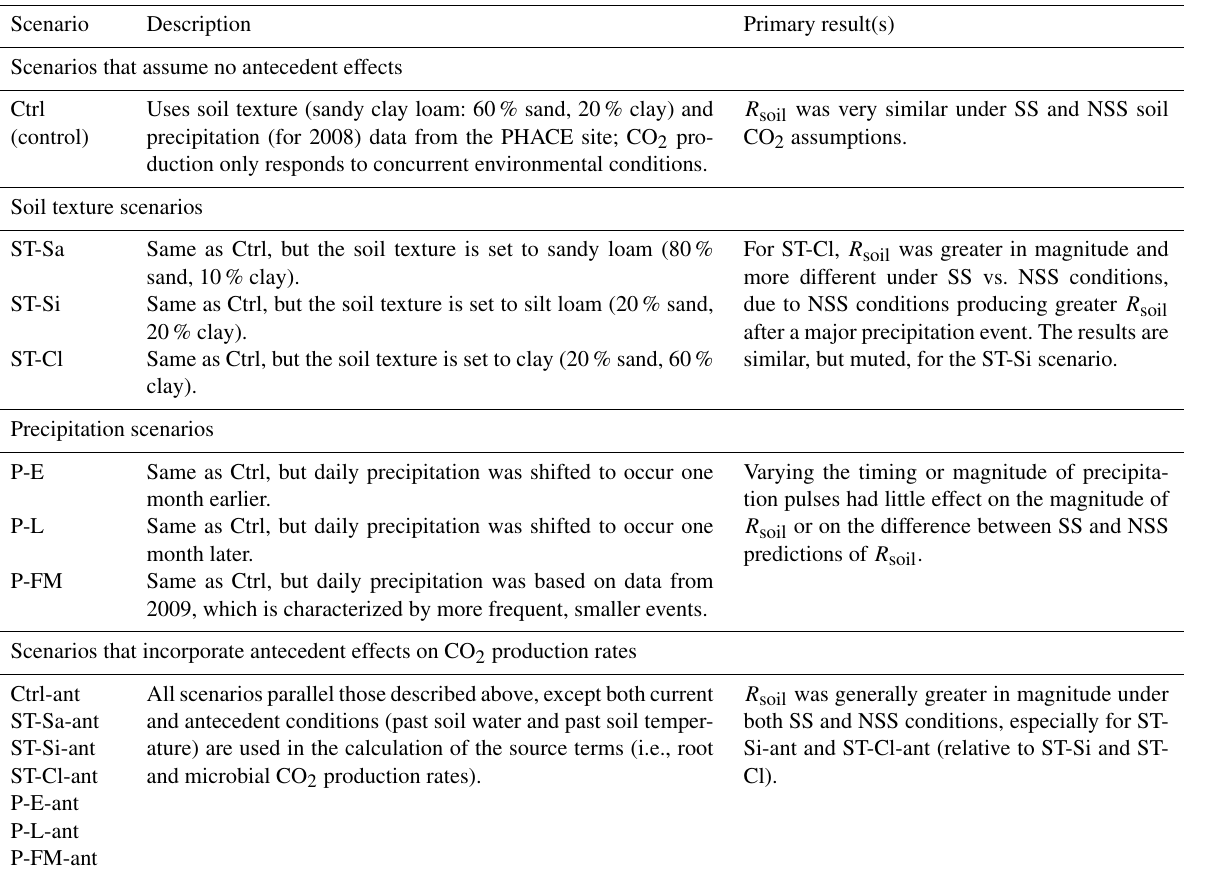
Table 3. The scenario code, description, and summary of results associated with each model scenario; the 14 scenarios below were applied to both the DETECT and SS-DETECT models. The scenarios involved a non-factorial combination of different soil texture, precipitation regimes, and inclusion/exclusion of antecedent effects on the root and microbial CO 2 production